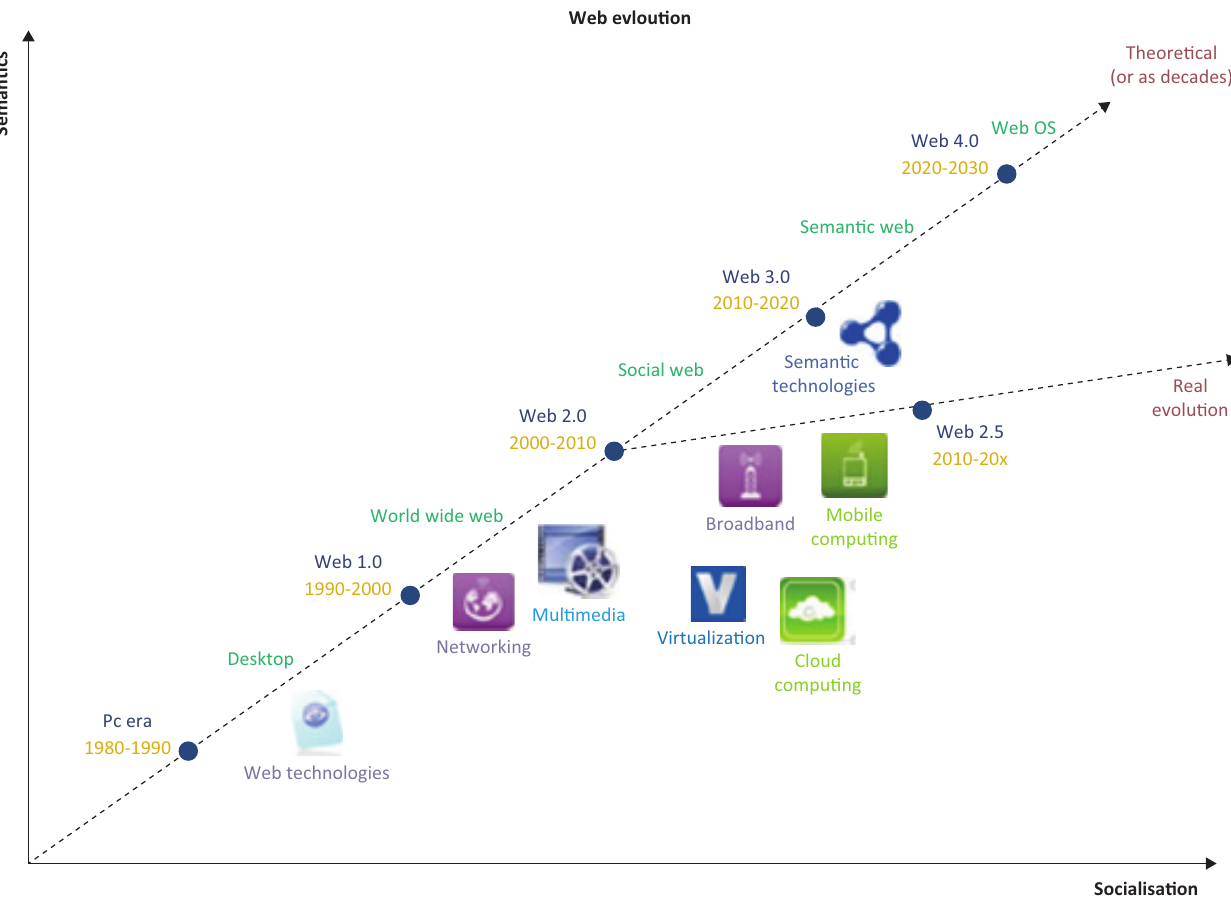
FIGURE 1: The evolution of the Web.